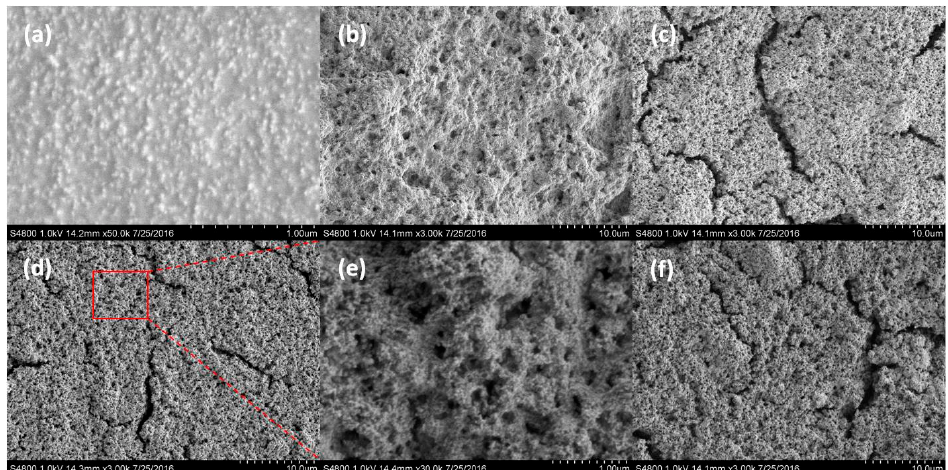
Figure 4. SEM images of PDMS-SiO 2 /SS hybrid coating with different mass ratios of PDMS-SiO 2 to SS. ( a ) 1:10; ( b ) 1:5; ( c ) 1:2; ( d , e ) 1:1; ( f ) 2:1.